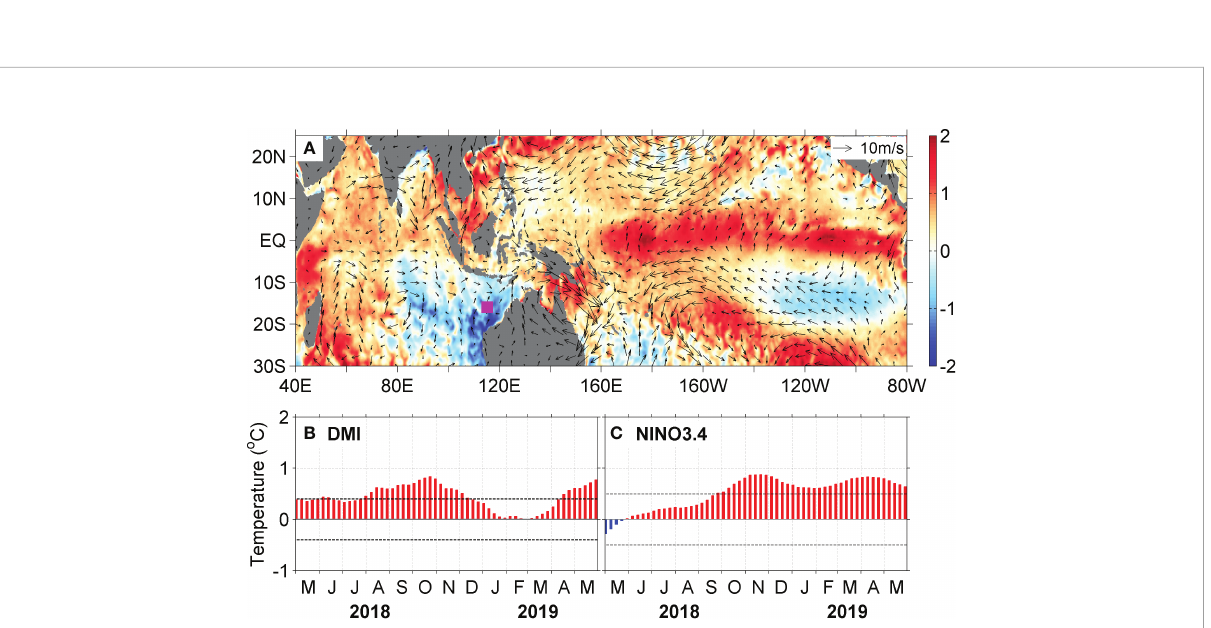
FIGURE 4 (A) Distribution of the tropical SST (shaded; °C) and wind (vectors; m s − 1 ) anomalies in December 2018. The magenta diamond denotes the position of the moored buoy. Time series of 3-month running mean (B) DMI (bars; °C) and (C) NINO3.4 SST anomalies (bars; °C) from May 2018 to May 2019. The dotted lines indicate the threshold of ±0.4°C (B) and 0.5°C (C) for the warm and cold periods, respectively.